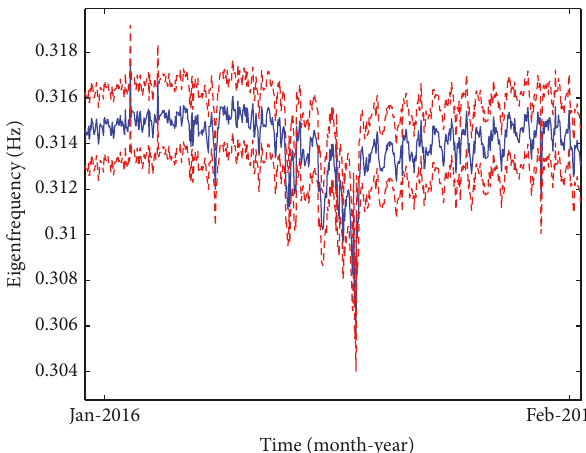
Figure 11: Trend of the first eigenfrequency (solid blue curve) and ±2𝜎 interval (dashed red curves).